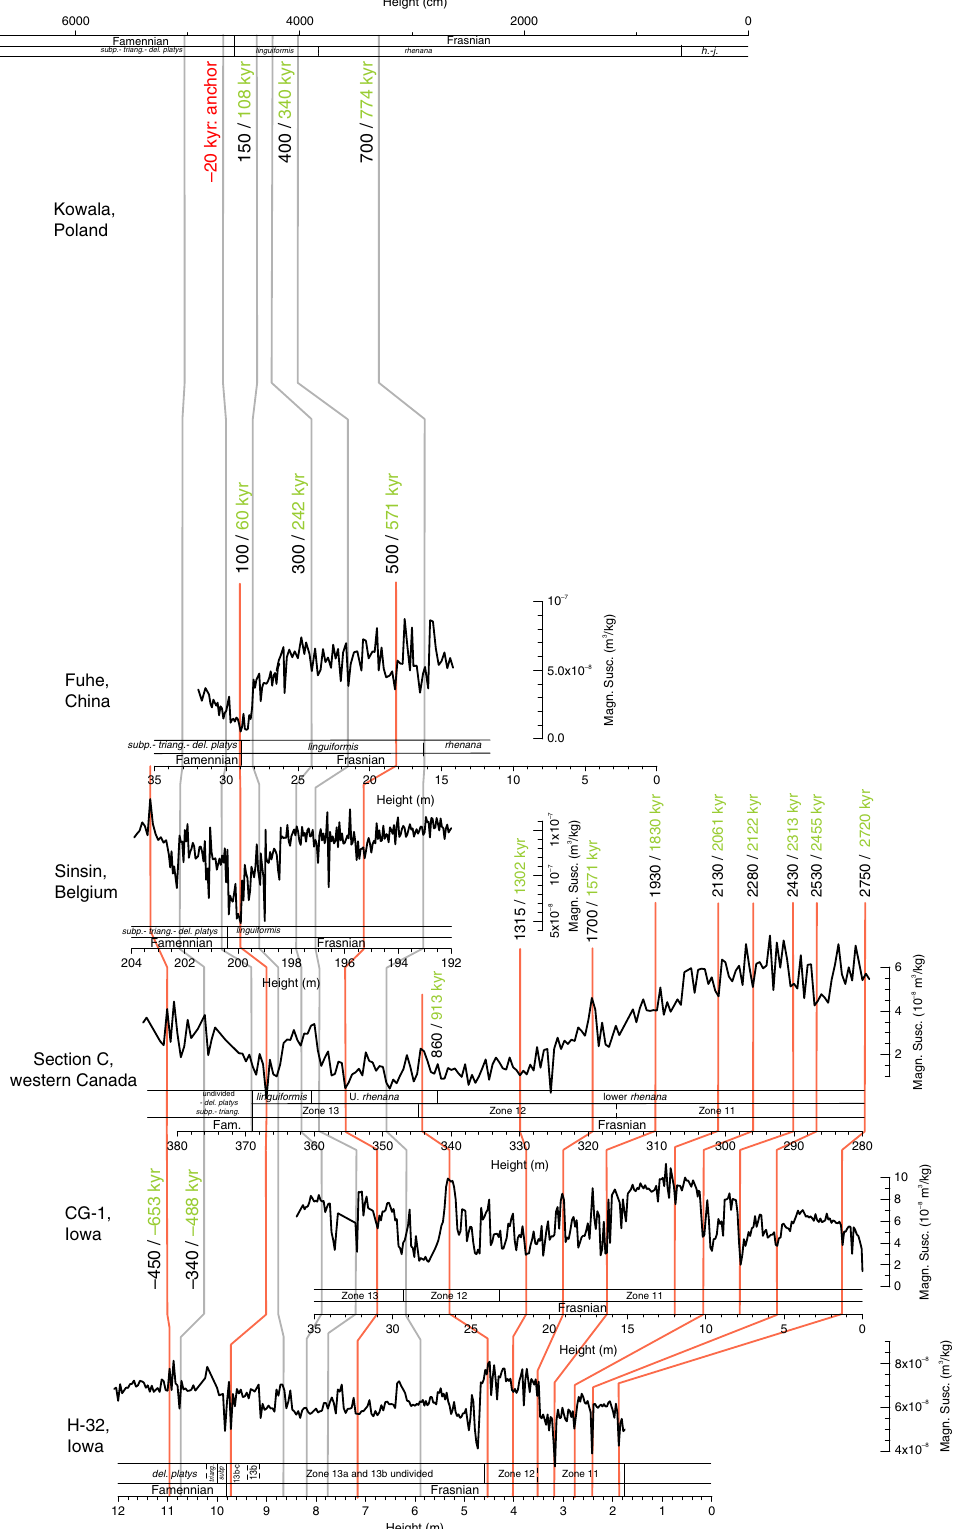
Fig. 5 Magnetic susceptibility correlation. Tie-points between H-32, CG-1, Section C, Sinsin, and Fuhe were obtained by visually correlating distinct features in magnetic susceptibility (red ties). The gray ties were established by correlating distinct features in carbon isotope geochemistry (Fig. 6). We construct a common fl oating age model for all sections by assigning an age relative to the F – F boundary to each tie-point, according to the existing astrochronologic framework of Section C and Kowala 15, 16 . These ages are listed in black. The tie-point ages listed in green indicate the “ optimized ” tie-point ages, after 5000 Monte Carlo simulations ( “ Methods ” ). The latter tie-point ages are used for the depth-to-time conversion used in Figs. 2 and 3. Fam. Famennian,